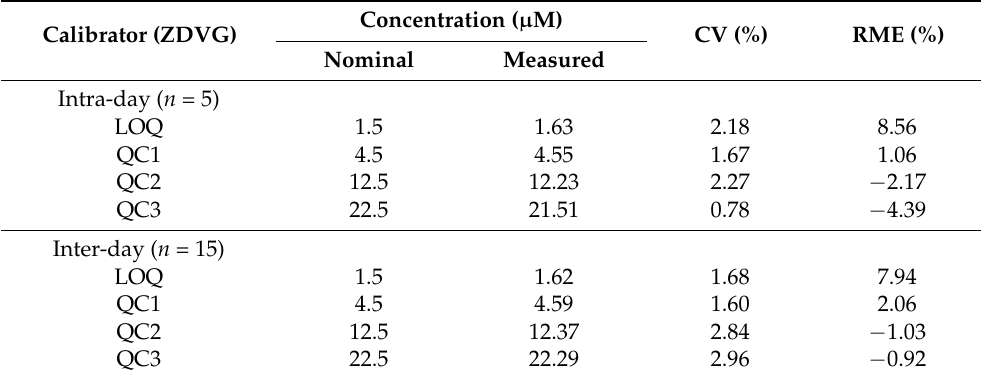
Table 2. Intra- and inter-day precision (% CV) and accuracy (% RME) of zidovudine glucuronides (ZDVG). Measurements were taken for five replicates per day for three days.